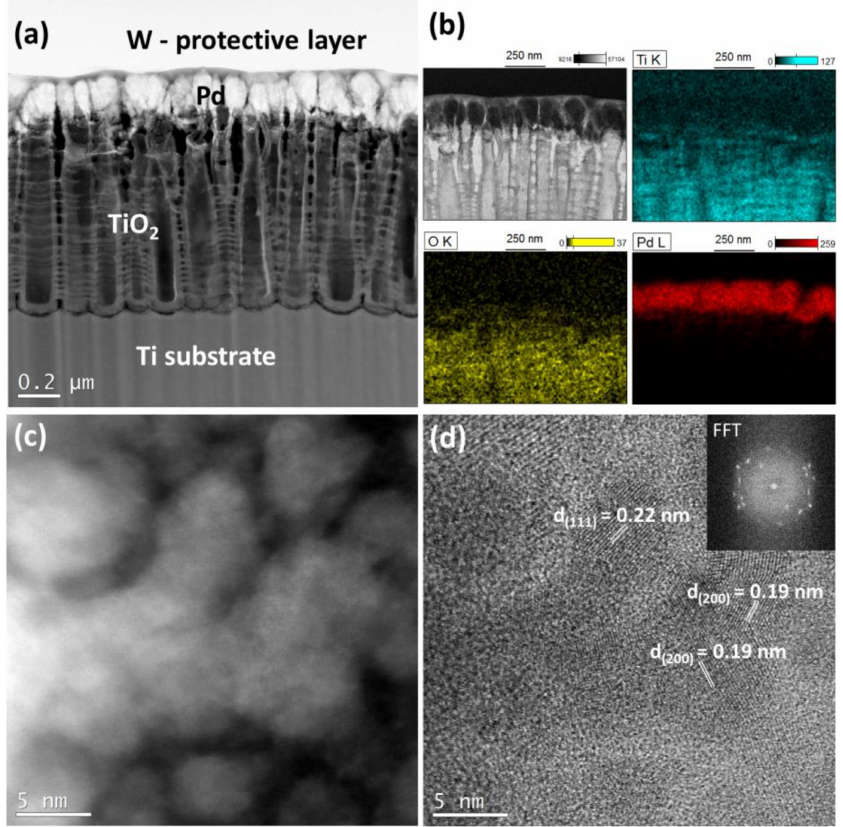
Figure 3. Cross-sectional view of titania nanotubes (25 V) decorated with Pd (magnetron sputtering technique) ( a ) HAADF-STEM image with visible layers, ( b ) EDS elemental maps indicating presence of Pd, ( c ) HAADF-STEM image taken from the Pd layer, and ( d ) high resolution STEM image showing a lattice spacing of Pd (111) and